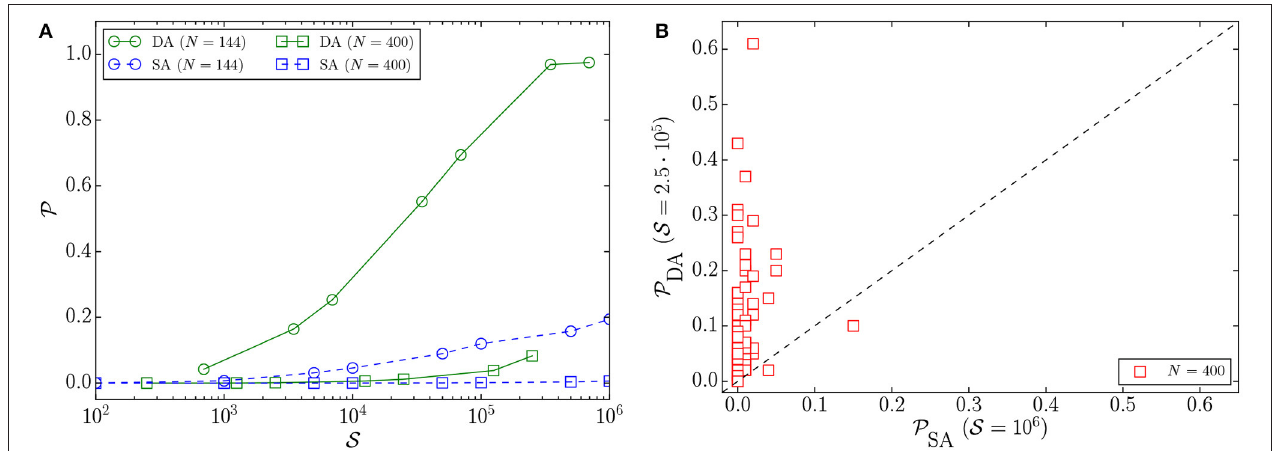
FIGURE 6 | (A) Mean success probabilities ( P ) vs. the number of Monte Carlo sweeps ( S ) for 2D-Gaussian problem instances with N = 144 and N = 400 variables solved by the DA and SA. The error bars are not included, for better visibility. (B) The success probability correlation of 100 2D-Gaussian instances with N = 400 variables. The data points are obtained considering 10 6 and 2.5 · 10 5 Monte Carlo sweeps for SA and the DA, respectively.